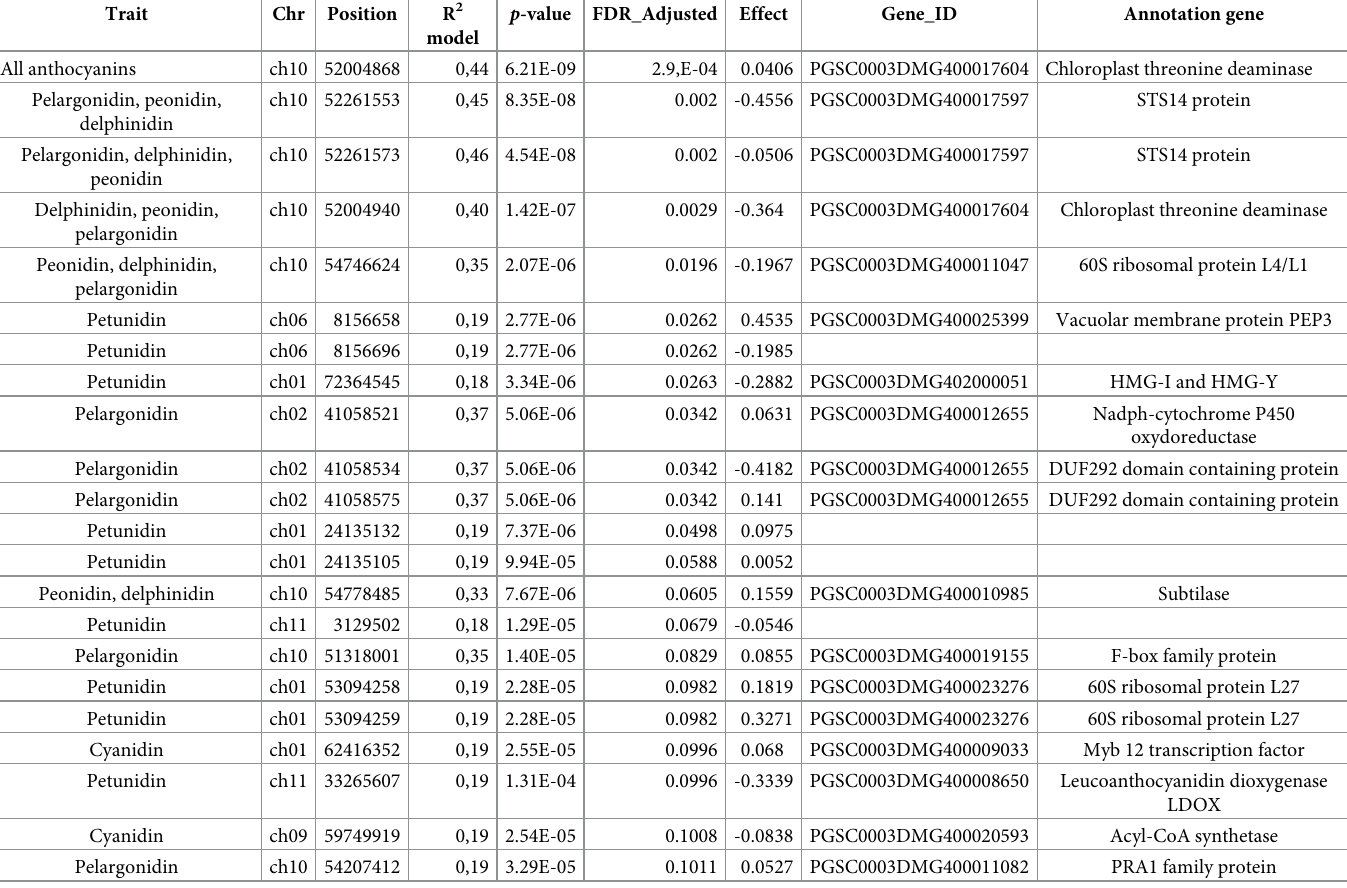
Table 1. Summary of genome associations for anthocyanin content in a population of Solanum tuberosum group Phureja.